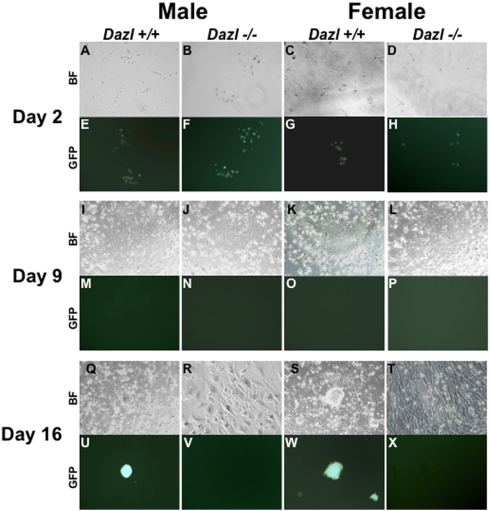

Dazl is required for Derivation of Embryonic Germ Cells Lines from E12.5 PGCs.Brightfield (BF) and GFP fluorescent images of Oct4ΔPE:GFP-positive PGCs during EG derivation on STO feeders from male and female E12.5 PGCs. (A–D) BF and (E–H) GFP expression of day 2 post-FACS wildtype and Dazl null PGCs. (I–L) BF of flattened, cobblestone like colonies at day 9 with no GFP expression (M–P). (Q–T) BF and (U–X) GFP expression in day 16 post-FACS cells, with only wildtype wells displaying EG colony formation (Q, S) and GFP expression (U, W).